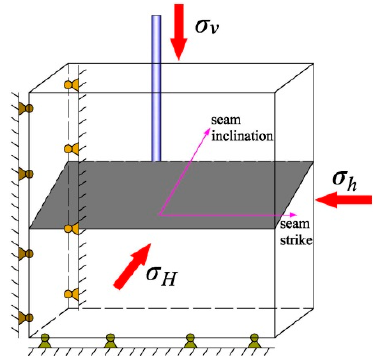
Figure 8. Schematic diagram showing the sample confinement (take β = 0 ˝ sample for example). Table 2. Test result of in-situ stress in Tonghua coalmine